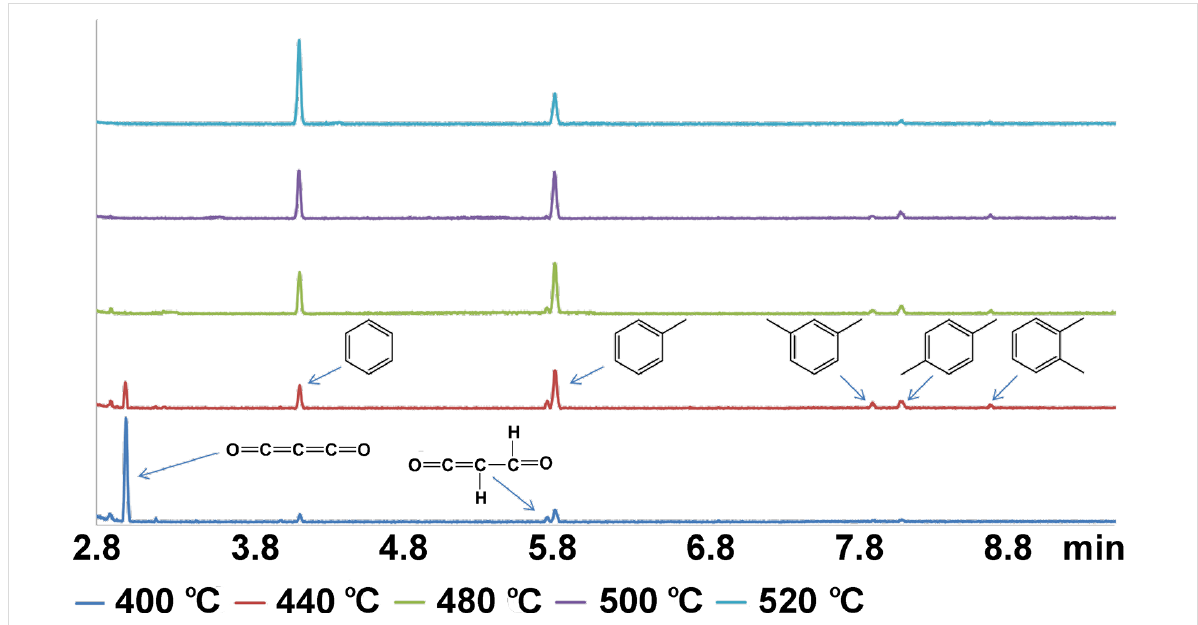
Figure 1: GC profile of the products formed during CO 2 hydrogenation at different temperatures.